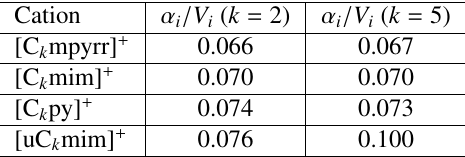
Table 1. IL-forming ions studied in this work